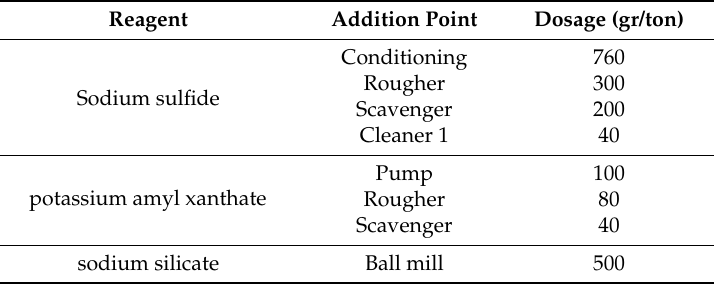
Table 3. Reagents dosage and addition points.